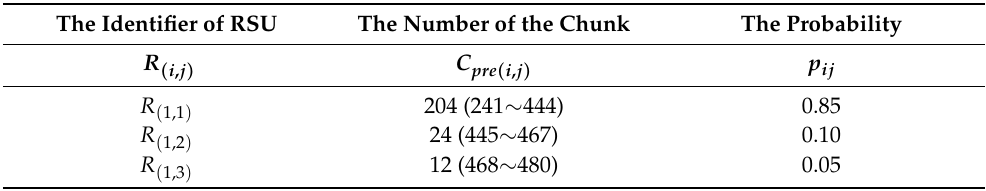
Figure 3. Correlation between entropy and prediction accuracy. Table 2. The amount of the content caching according to the